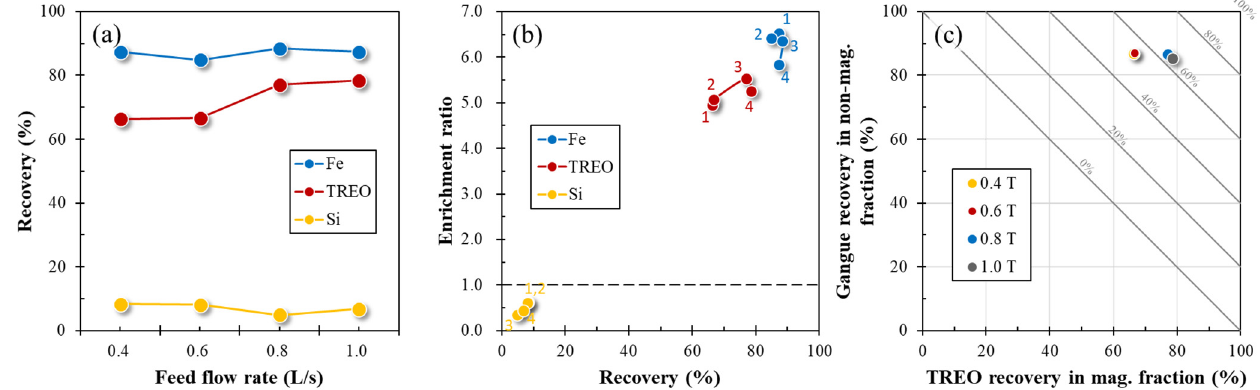
Figure 10. Effect of magnetic induction on ( a ) the recovery of TREO, Fe, and Si from REE ore, ( b ) enrichment ratio as a function of recovery, and ( c ) relationship between TREO recovery in magnetic fraction and gangue recovery in non-magnetic fraction. Note: The numbers in Figure 10b denote that the magnetic induction (1: 0.4 T, 2: 0.6 T, 3: 0.8 T, 4: 1.0